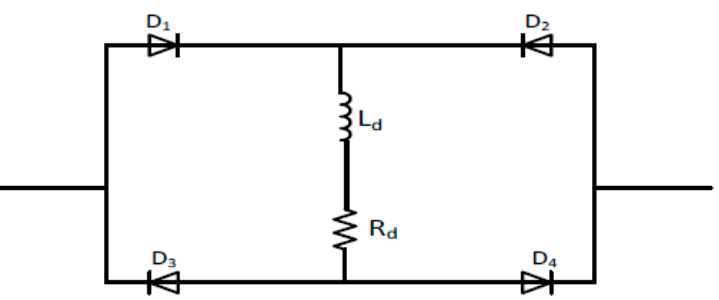
Figure 19. Structure of direct current link FCL.